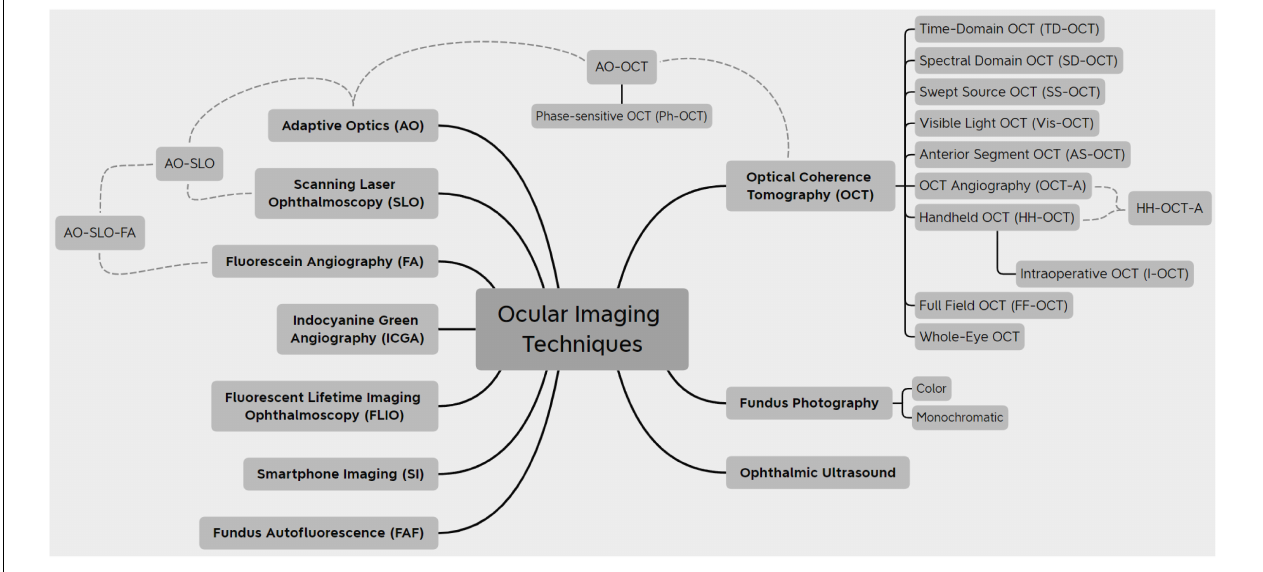
FIGURE 9 | A summary of the modern ocular imaging